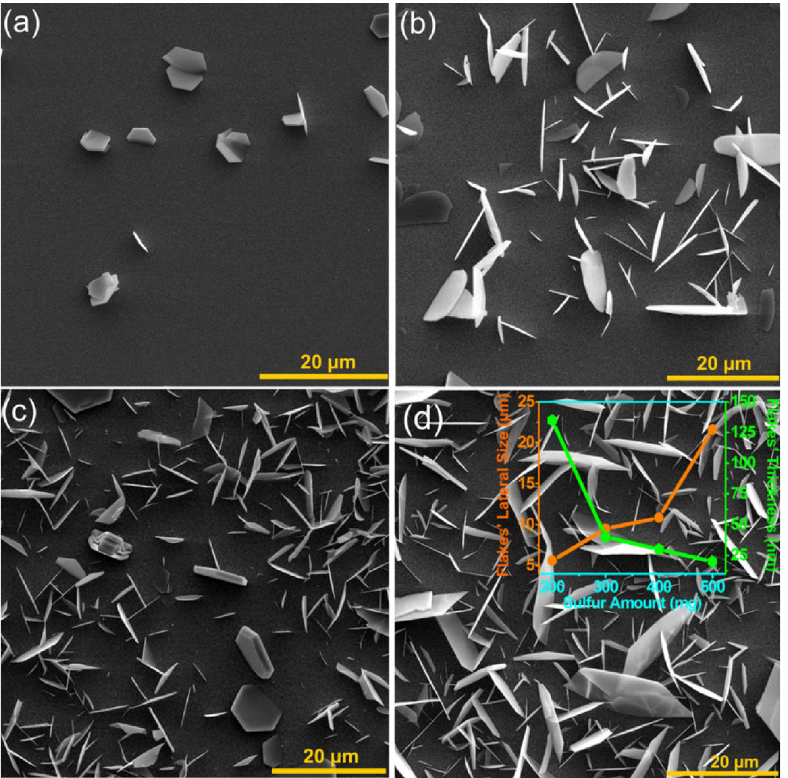
Figure 3. The effect of sulfure amount on the SnS 2 nanosheets morphology on FTO substrate through modified CVD. ( a ) 200 mg, ( b ) 300 mg, ( c ) 400 mg and ( d ) 500 mg.The inset shows the evolution of average lateral size and thickness of grown SnS 2 nanosheets by different sulfur